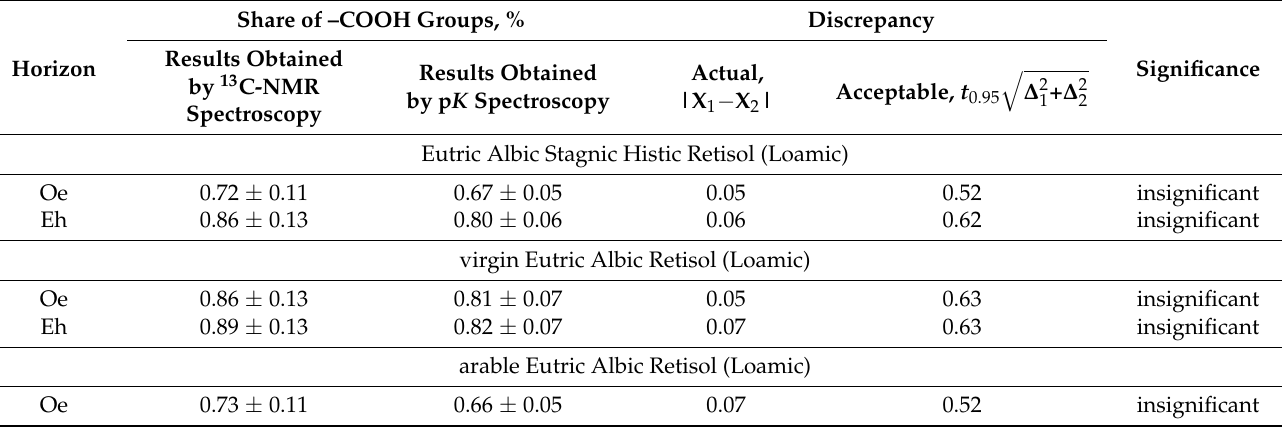
Table 4. Relative content of acid–base groups in the composition of fulvic acids. Share of –COOH Groups, % Horizon